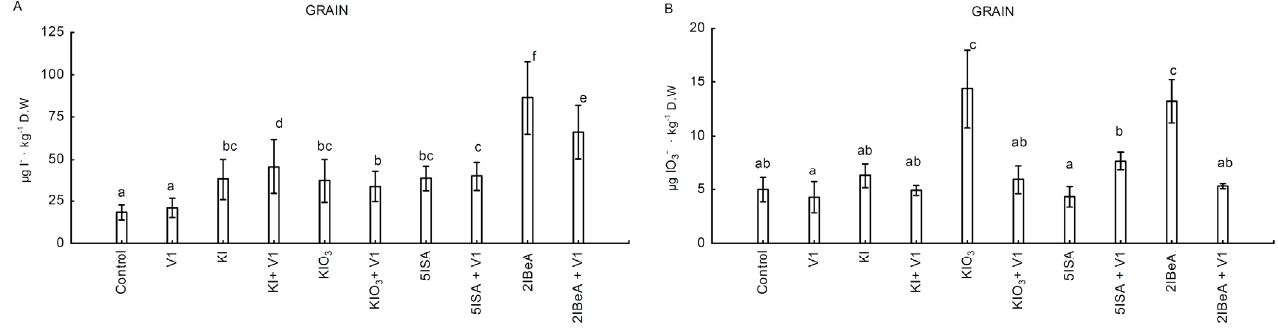
Figure 2. Content of iodide [I − ] ( A ) iodates [IO 3 − ] ion ( B ) in sweet corn grain in experiment No. 3. Results only from 1 year of study (2020). Means followed by different letters for treatments differ significantly at p < 0.05 ( n = 8). Bars indicate standard error.